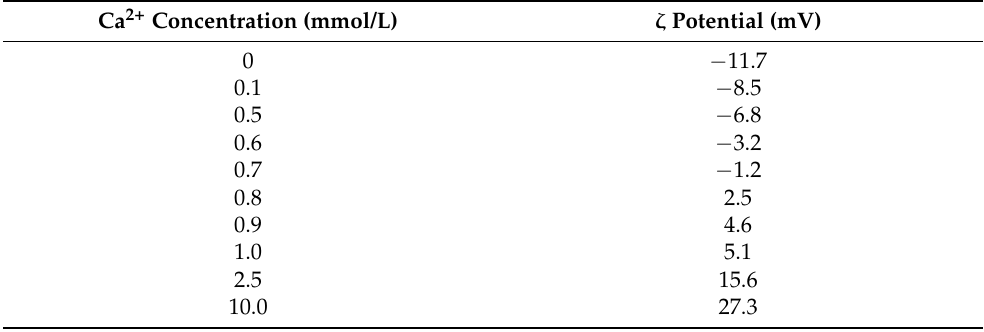
Table 9. Measured zeta potential of C-S-H as a function of calcium concentration [186]. Ca 2+ Concentration